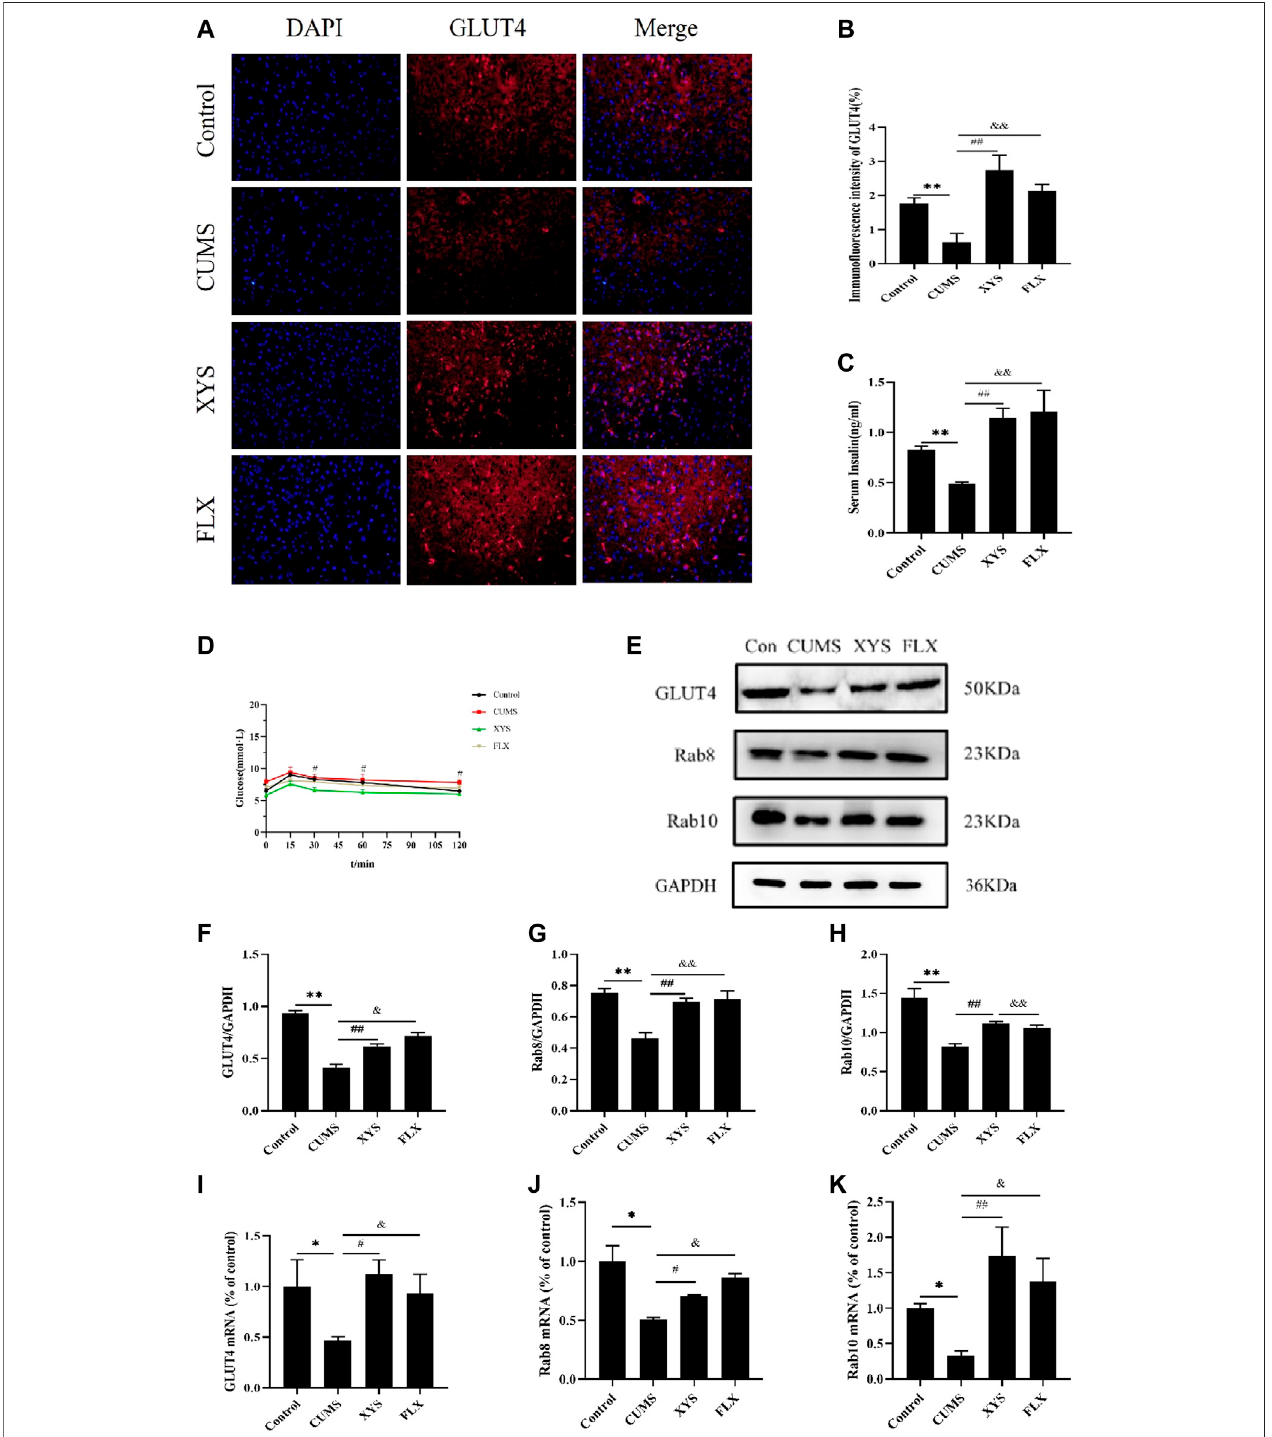
FIGURE5| EffectofXiaoyaosanonglucosemetabolisminhypothalamusofCUMS-inducedmice. (A) Immuno fl uorescenceexpressionofGLUT4inhypothalamus ofthemice(scalebar=20 µm). (B) Immuno fl uorescenceintensityofGLUT4(%)(F(3,8)=9.938, p =0.0045,n=3). (C) Seruminsulinlevelofthemice(F(3,16)=7.973, p =0.0018,n=5). (D) Thebloodglucoseofthemice(F(3,36)=2.542, p =0.0716,n=10). (E) RepresentativewesternblottingofGLUT4,Rab8andRab10expressions. (F) Quantitative analysisof protein levels of GLUT4 (F(3, 16) = 57.780, p < 0.0001, n =5). (G) Quantitative analysisof protein levels ofRab8 (F(3, 16) = 13.041, p = 0.0001, n = 5). (H) Quantitative analysis of protein levels of Rab10 (F (3, 16) = 14.085, p < 0.0001, n = 5). (I) The expression of GLUT4 mRNA (F (3, 12) = 2.542, p = 0.1054, n = 4). (J) The expression of Rab8 mRNA (F (3, 12) = 9.332, p = 0.0018, n = 4). (K) The expression of Rab10 mRNA (F (3, 12) = 5.218, p = 0.0155, n = 4). The valuesrepresentthemean±SEM. p p < 0.05or pp p < 0.01comparedwiththecontrolgroup.# p < 0.05,## p < 0.01comparedwiththeCUMSgroup.& p < 0.05,& p < 0.01 compared with the CUMS